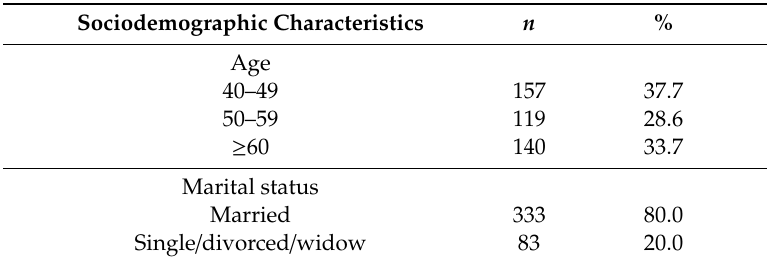
Table 1. Sociodemographic characteristics of the participants ( n =